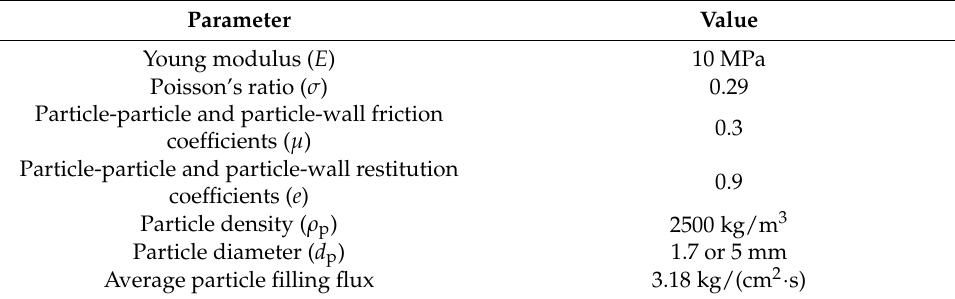
Table 2. Reference parameters employed in the